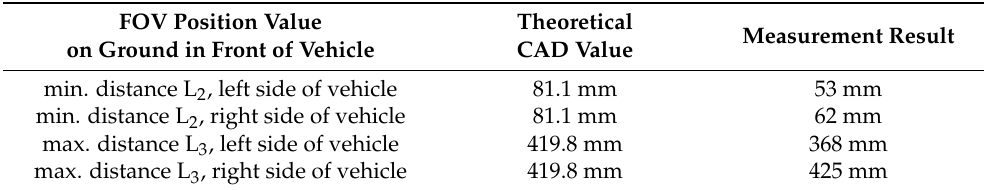
Table 2. Experimental results for the FOV position on the ground in front of the prototype vehicle. Definitions of the position values are in Figure 3; theoretical CAD values are identical to Table